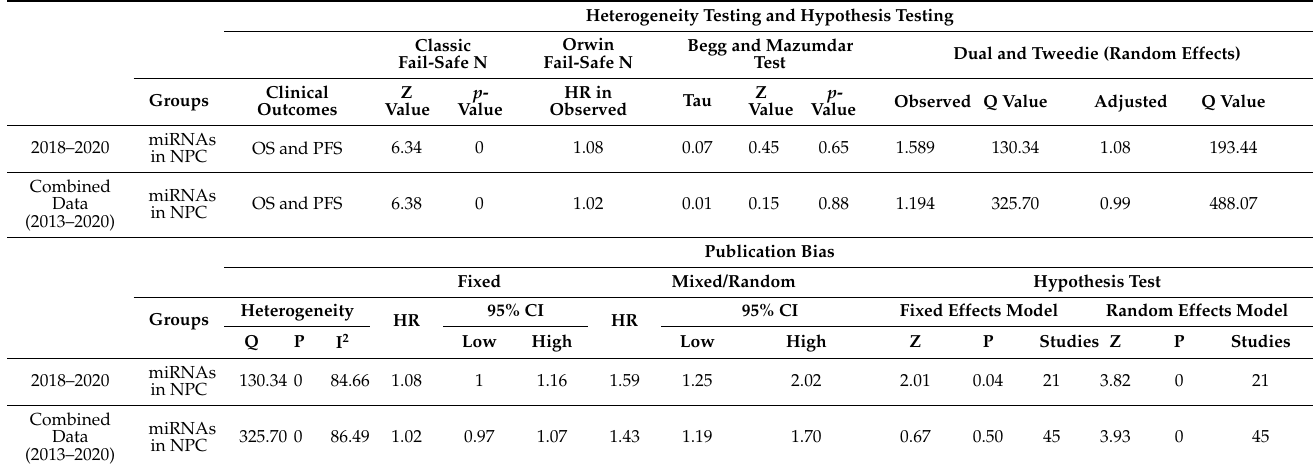
Table 3. The heterogeneity and hypothesis testing of the included studies in the